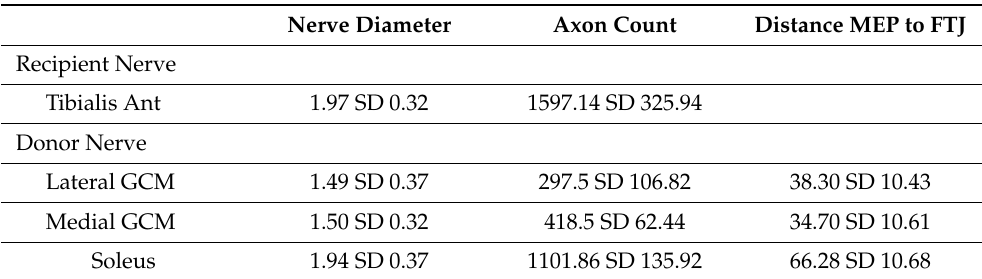
Table 1. Nerve specifications showing the nerve diameter, the axon count and the distance from motor entry point (MEP) to the femorotibial joint (FTJ) for the investigated muscle branches with mean and standard deviation (SD).